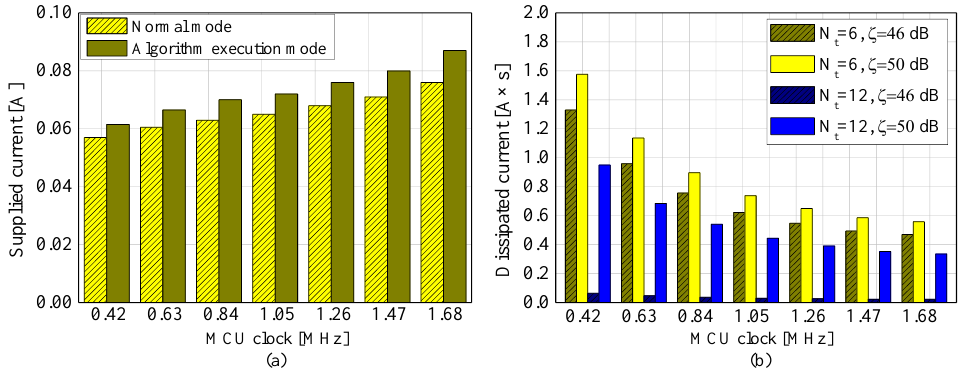
Figure 12. ( a ) The supplied current versus M when the proposed algorithm is executed (execu- tion mode) or not (normal mode). ( b ) The dissipated current (=supplied current × execution time) versus M